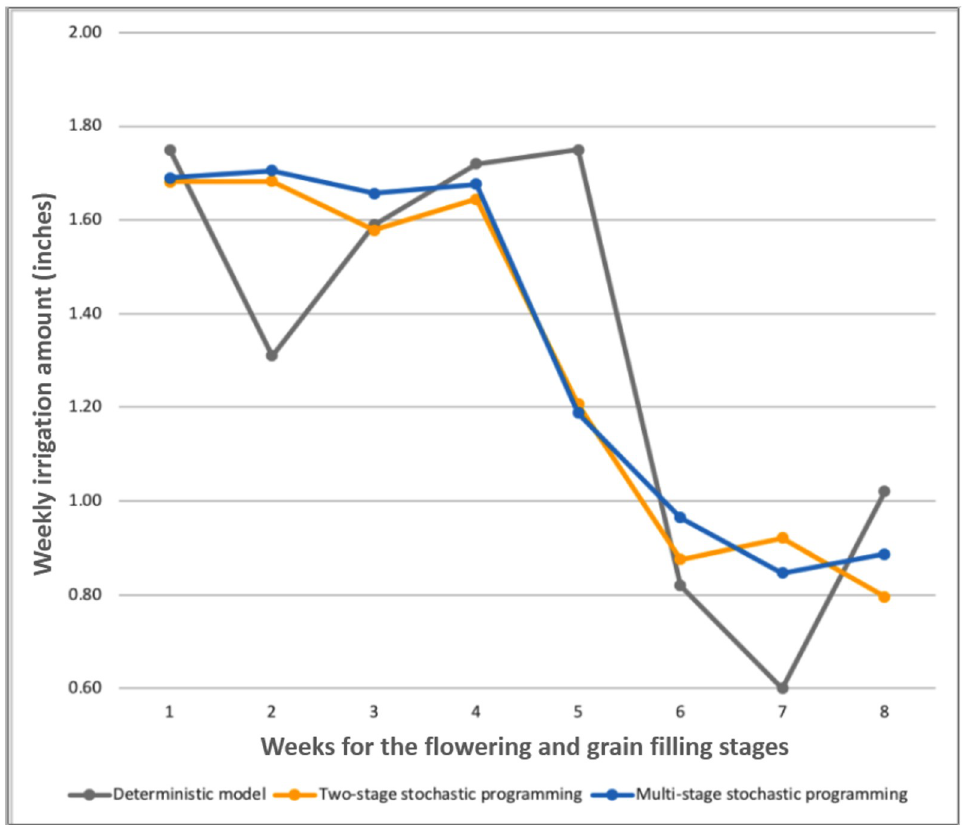
Fig 5. Comparison of weekly irrigation amounts among different models